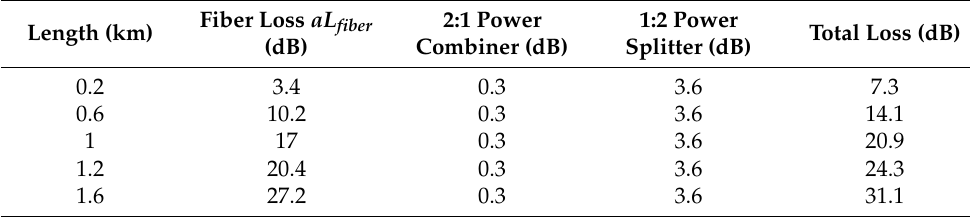
Table 5. Analysis of loss budget in the proposed scheme.